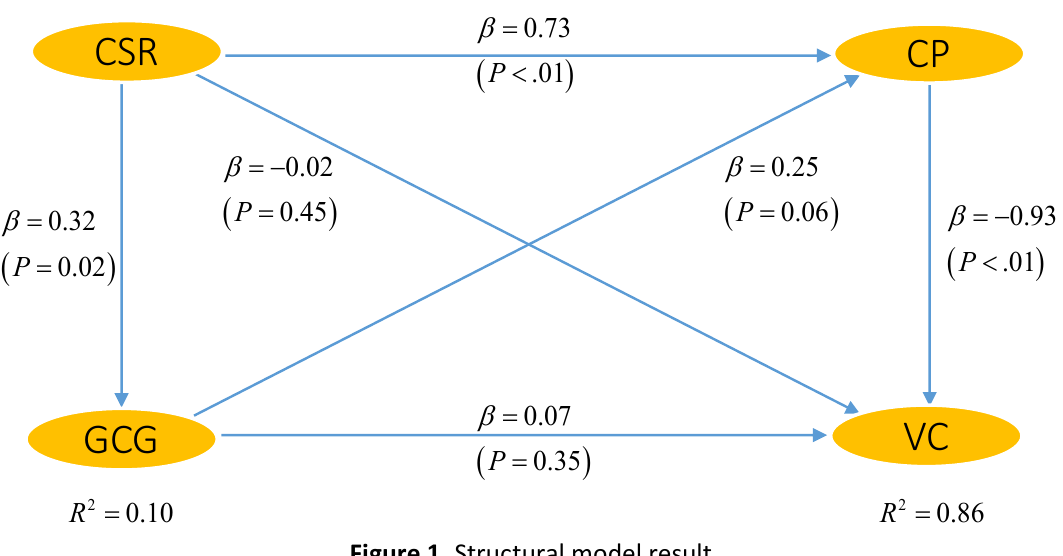
Figure 1. Structural model